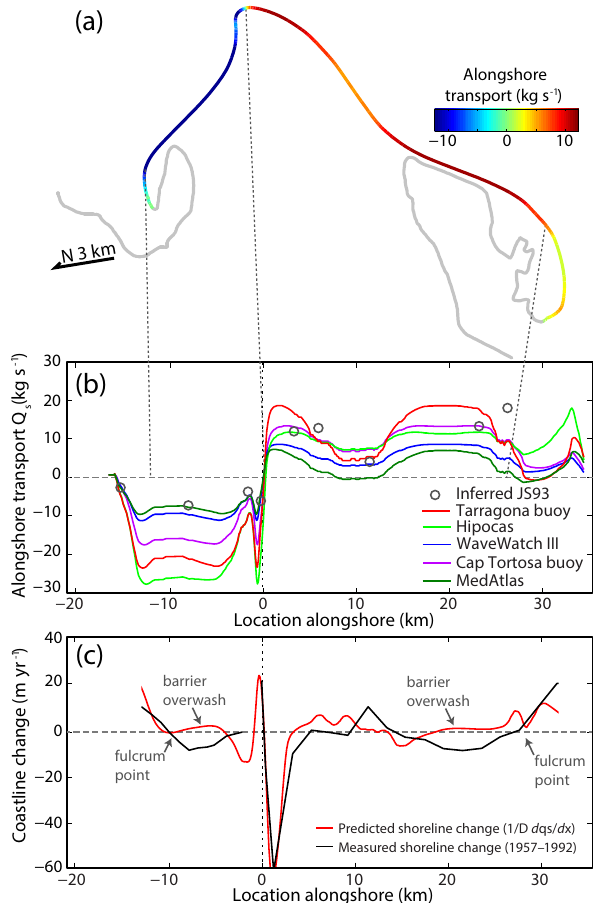
Figure 4. (a) The Ebro Delta coastline, colored by the simu- lated alongshore sediment transport flux from the Cap Tortosa data. (b) Alongshore sediment transport along the Ebro Delta coastline from all five wave climate sources (and assuming no sediment was supplied by the Ebro River). Alongshore transport is positive to the right when looking offshore. Black markers indicate along- shore sediment transport estimates from Jiménez and Sánchez- Arcilla (1993). (c) The Cap Tortosa buoy data recast into shoreline change rates using the one-contour-line approach (Eq. 2) compared to the measured shoreline change rates from Jiménez and Sánchez- Arcilla